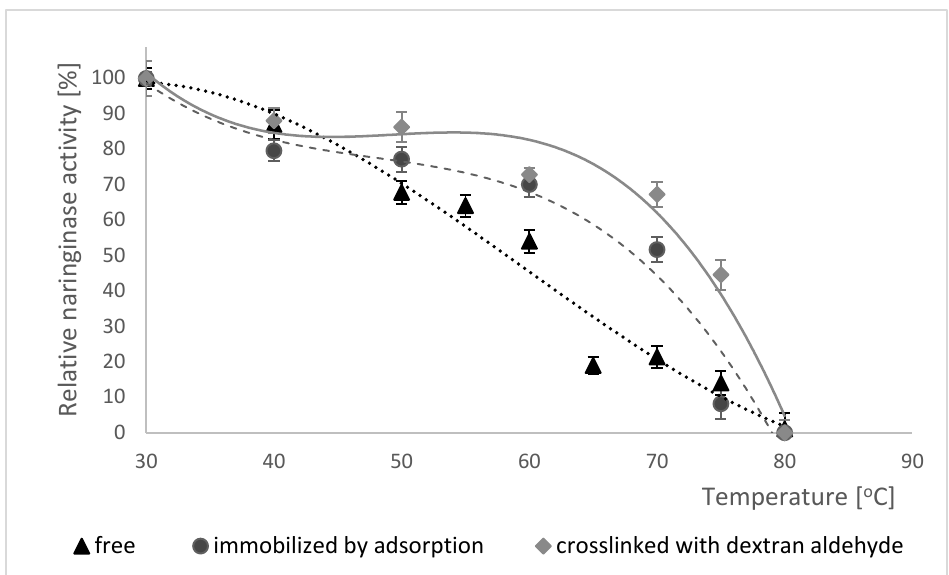
Figure 6. Thermal stability of free naringinase, naringinase immobilized by adsorption and naringinase crosslinked with dextran aldehyde from A. niger KMS. Activity of free naringinase (100% = 796 µmol min −1 g −1 of the preparation); Activity of naringinase immobilized by adsorption (100% = 16.26 µmol min −1 g −1 of the carrier); Activity of naringinase crosslinked with dextran aldehyde (100% = 16.34 µmol min −1 g −1 of the carrier). Enzyme activity was determined at 50 °C in buffer with pH 4.0.